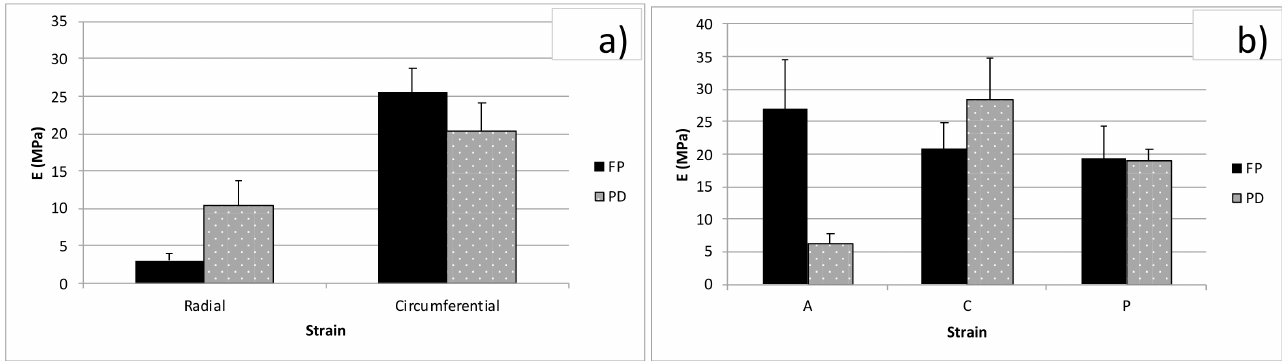
Figure 6. Comparison between tensile moduli for FD and PD menisci at the 0.12 strain level for ( a ) two directions—radial and circumferential—and for ( b ) different zones—A, C, and P—for circumferential samples. Bars are standard